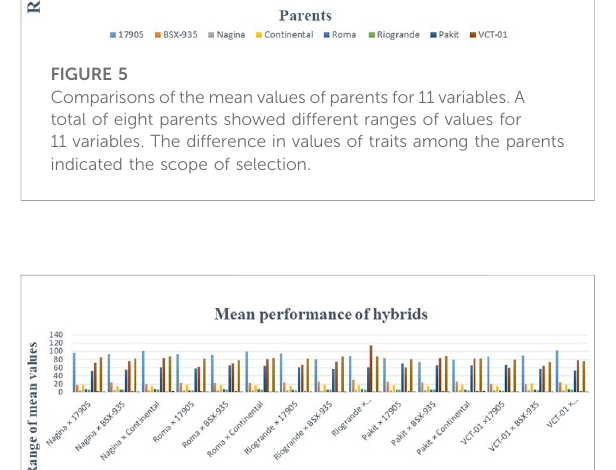
FIGURE 6 Comparisons of the mean values of hybrids for 11 variables. A total of 15 hybrids showed different ranges of values for 11 variables. The difference in values of traits among the hybrids indicated the scope of selection for varietal